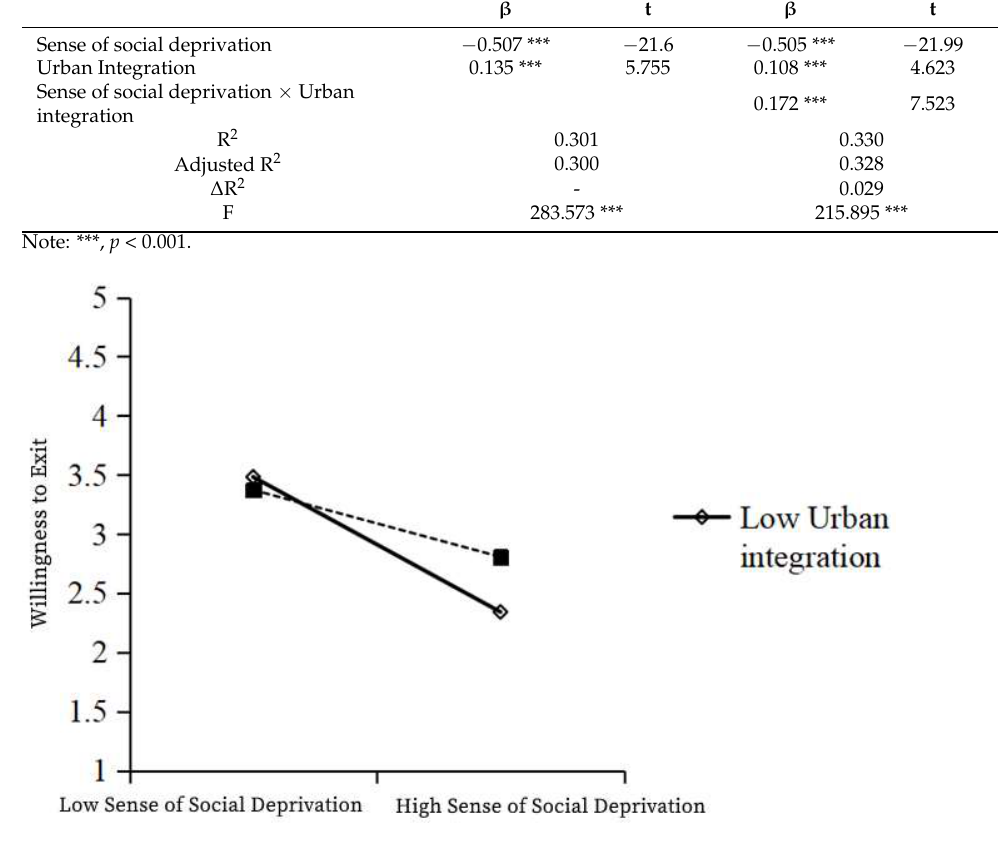
Figure 5. Moderating effect of urban integration between the sense of social deprivation and willingness to withdraw.